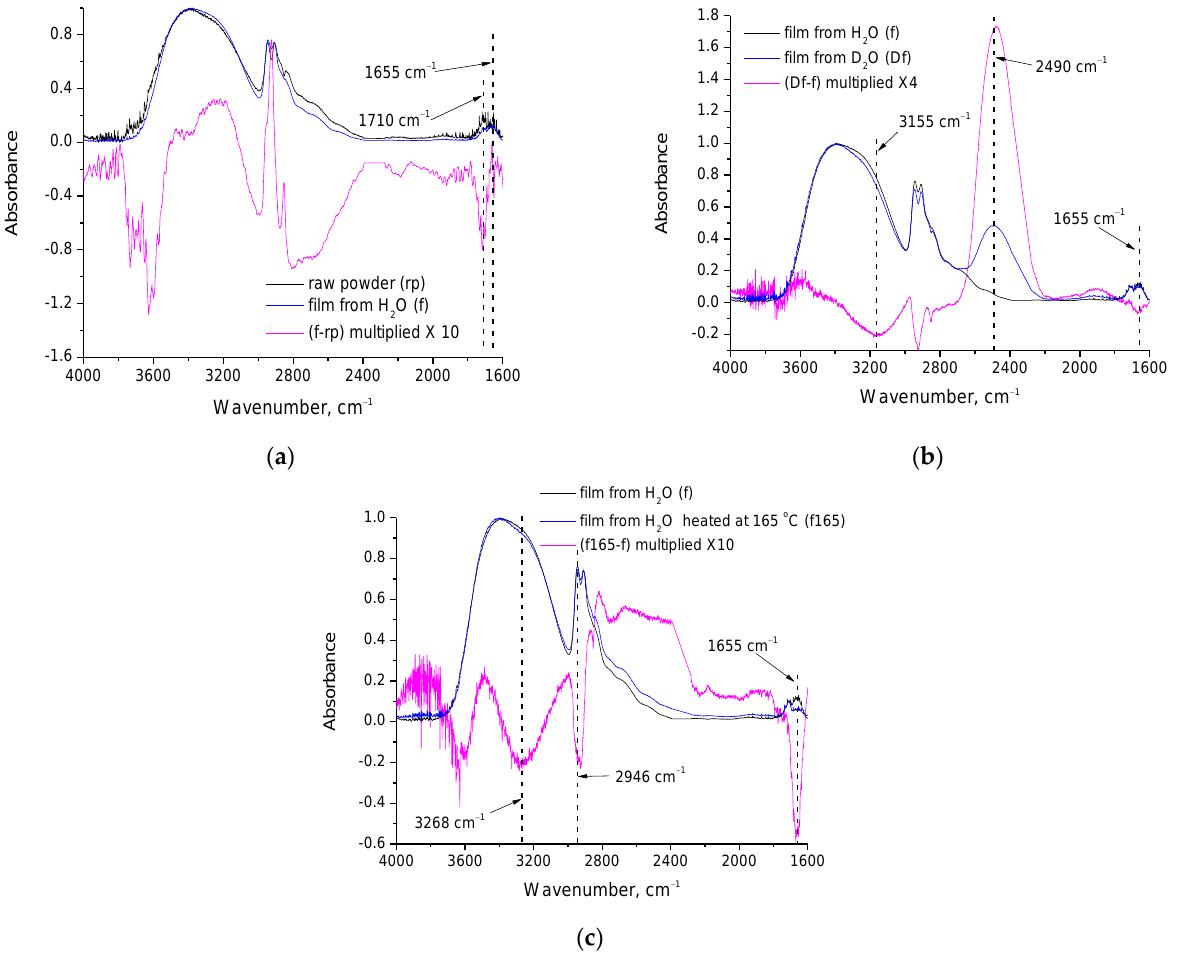
Figure 4. FTIR spectra and their subtracted spectrum of: ( a ) PVA raw powder and film; ( b ) film from H 2 O and film from D 2 O; ( c ) film from H 2 O before and after heating at 165 °C. In Figure 4b, the spectra of films cast from PVA solutions in H 2 O and D 2 O and their subtracted spectrum are presented. The presence of D 2 O residues in the respective film is confirmed from the strong absorption at 2490 cm −1 [25]. At 1665 cm −1 (water bending vibration) a small negative peak exists in the subtracted spectrum, which indicates that H 2 O has decreased in the film cast from the D 2 O solution. However, the absorption band at this wavenumber is still present in the spectrum of the film from D 2 O, which suggests that H 2 O is not fully removed during dissolution/film casting, and therefore, that H 2 O must be strongly bound. The negative peak at 3155 cm −1 points out that some highly shifted (strongly bound) OH groups are missing in the film from D 2 O. The OH stretching vibration at this wavenumber cannot be attributed to water [25], and thus, this vibration is mainly assigned to PVA’s OH groups. Consequently, we are led to conclude that these highly shifted OH groups of PVA are reduced in the D 2 O film because such OH groups of the polymer were involved in hydrogen bonds with the H 2 O, which have been re- moved. The low wavenumber suggests that these OH groups of PVA should have been involved in multiple hydrogen bonds with water. This agrees with the previous conclu- sion that water must be strongly bound since is not fully removed by the film casting procedure. This also suggests that water, to some extent, may act as a crosslinker for PVA since water molecules can form up to four hydrogen bonds with four different OH groups of PVA. Regarding the differences among films from H 2 O before and after heating at 165 °C (see respective spectra in Figure 4c), a clear reduction of water content after heating is revealed from the intense negative peak at 1655 cm −1 (assigned to water bending vibration [25]) in the subtracted spectrum. Intense negative peaks in the C-H region (2800 – 3000 cm −1 ) are also observed along with various negative peaks in the O-H stretching vibration region (3100 – 3700 cm −1 ). In order to critically discuss these results, curve fitting (with Gauss peaks) was performed in the negative peak of the subtracted spectra ([Spectra of the film from D 2 O] − [Spectra of the film from H 2 O]) and ([Spectra of the film from H 2 O heated at 165 °C] − [Spectra of the film from H 2 O]). The fitted curves are presented in Figure 5, and the wavenumbers and percentage areas of the fitted peaks are presented in Table 2.